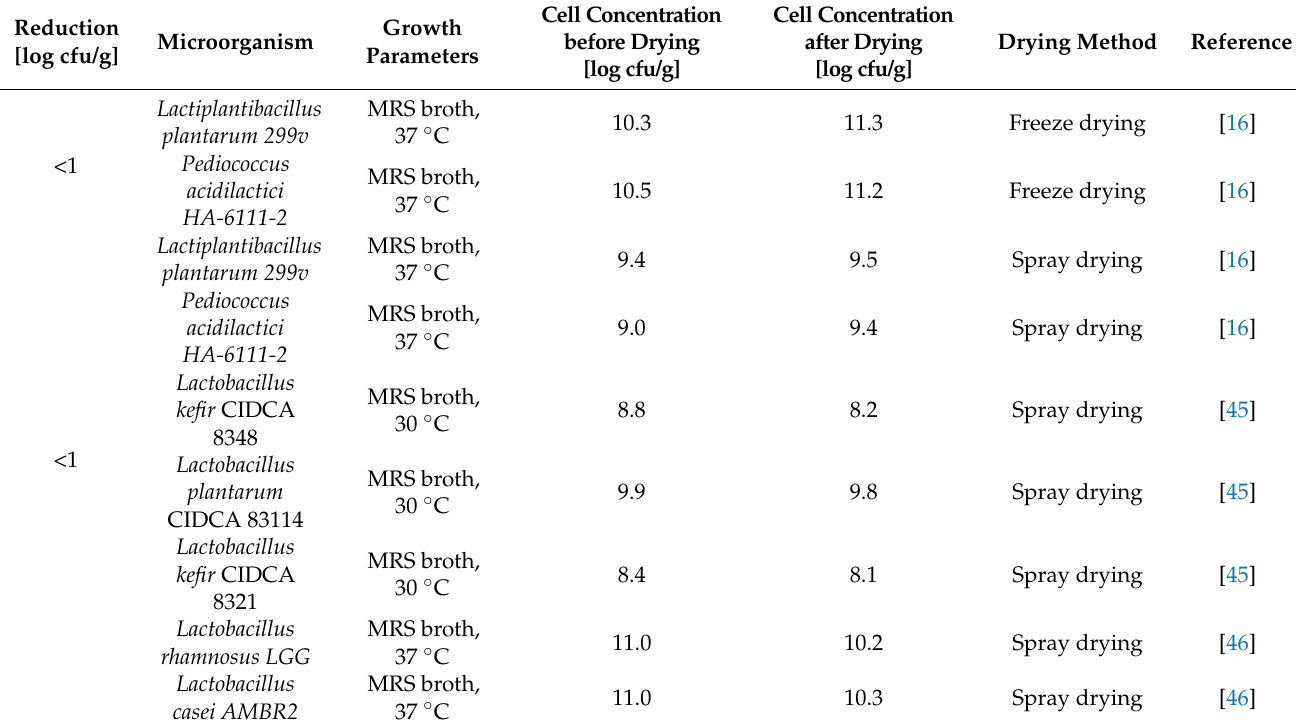
Table 1. Comparison of cell concentrations after different drying